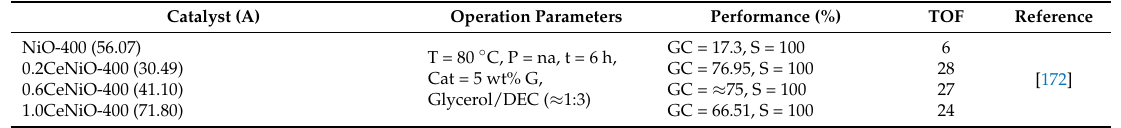
Table 12. Performance of some catalysts in the conversion of glycerol to glycerol carbonate as reported in some